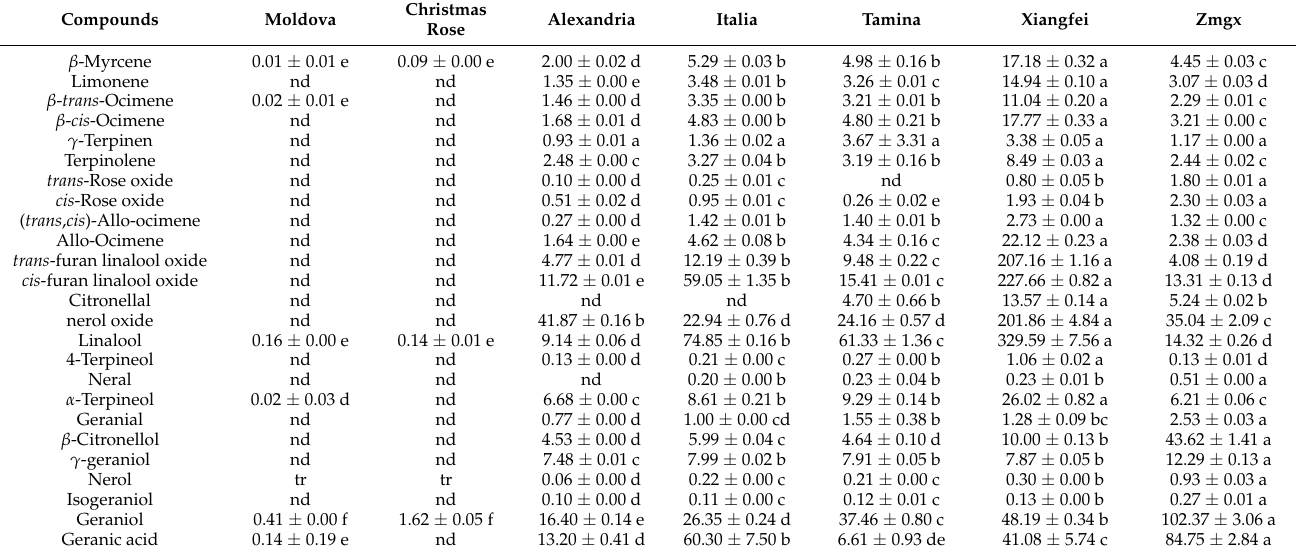
Table 2. Concentrations of monoterpenoids compounds in different table grape varieties at harvest in 2014 ( µ g/L). “nd” represented “Not detected”. “tr” represented “Trace amount”. Data were shown as means ± standard deviations of duplicate tests. Values with different letters (a–f) on a row were significantly different based on Tukey’s multiple range test ( p < 0.05). ‘Alexandria’ represented